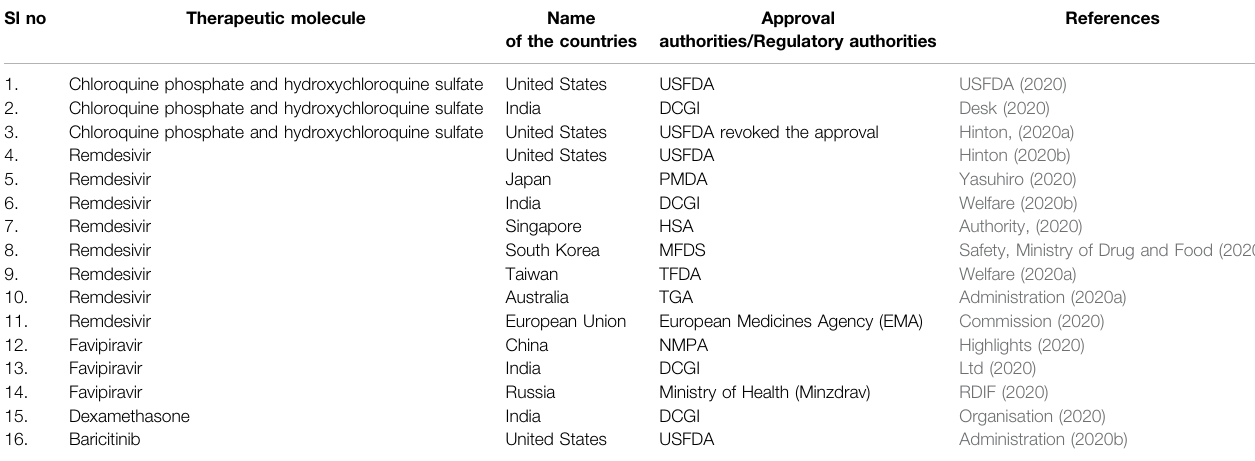
TABLE 3 | List of emergency approval or withdrawal of various therapeutic molecules to treat COVID-19